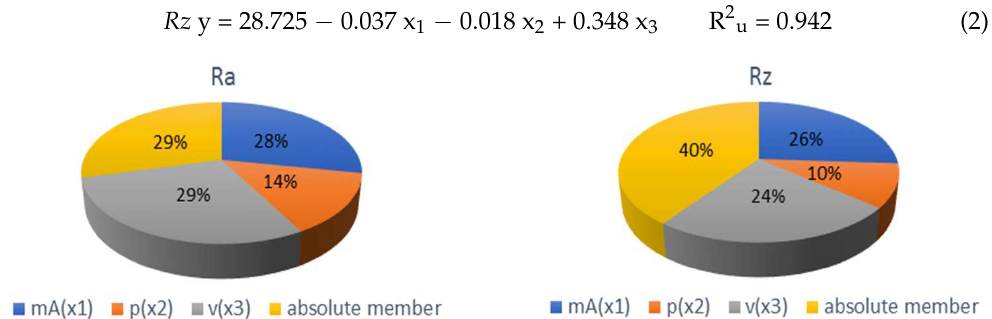
Figure 12. Graph of significance of mathematical model parameters for Ra and Rz roughness parameters.